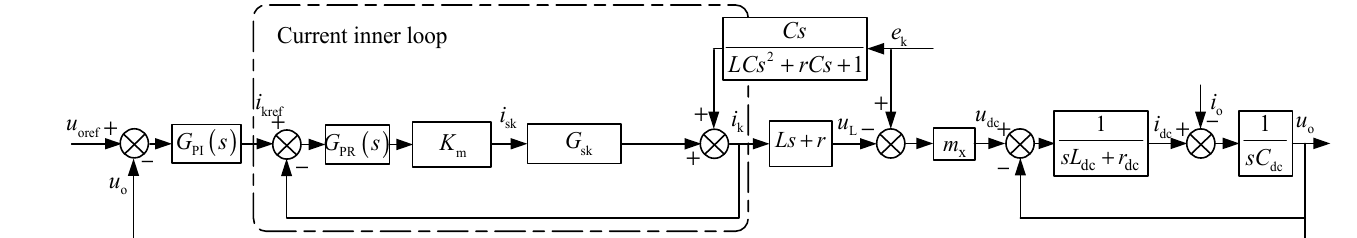
Figure 2. Double closed-loop control block diagram.